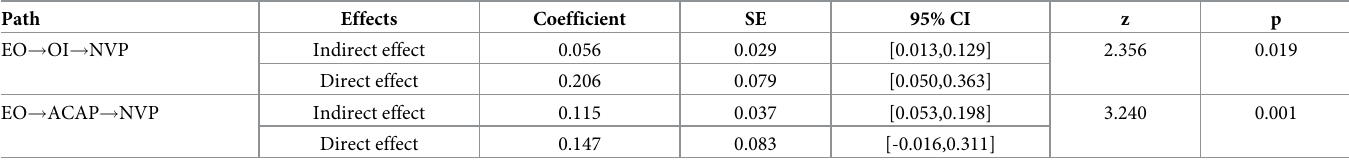
Table 4. Bootstrapping and Sobel test estimates for